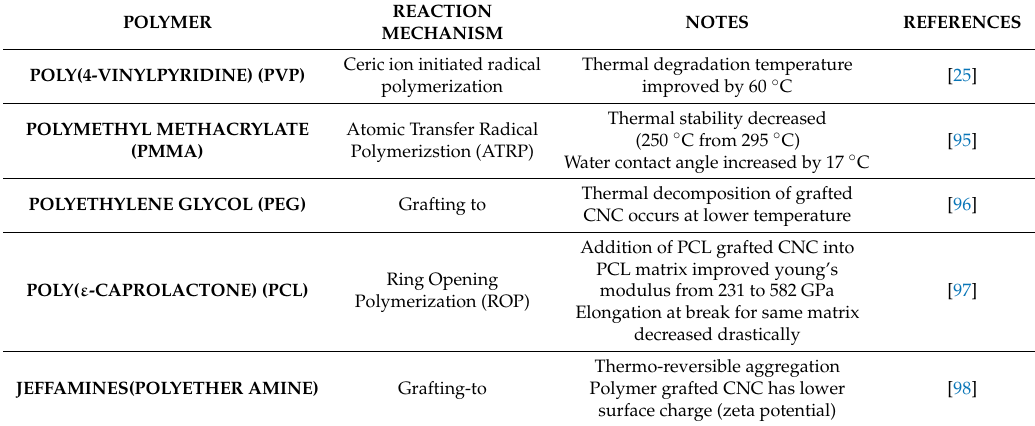
Table 3. Polymer Grafted